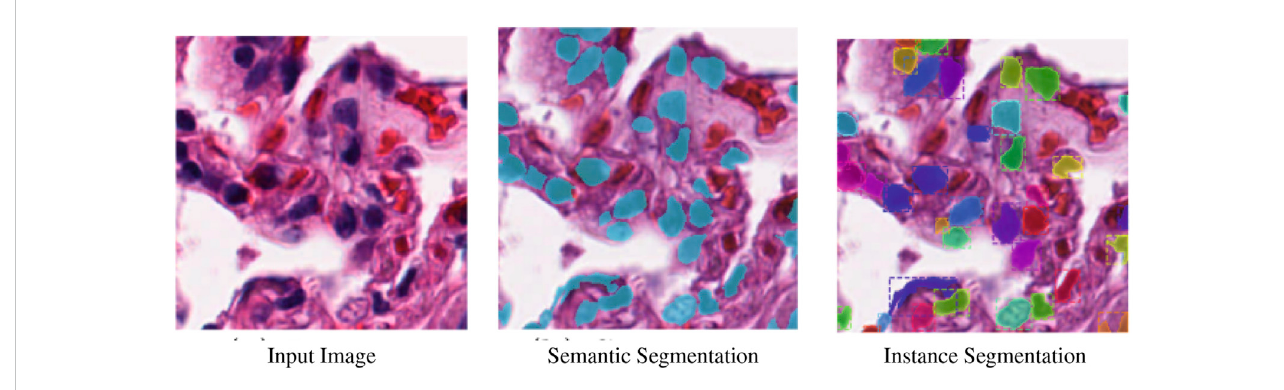
FIGURE 1 Semantic segmentation vs. instance segmentation (Zhang et al.,